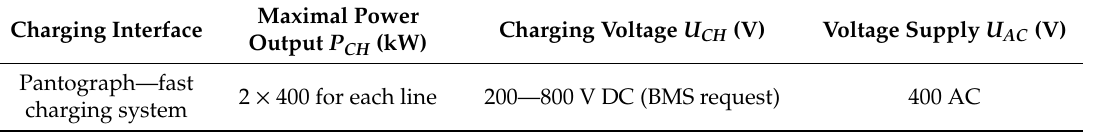
Table 5. Technical parameters of charging points on the Wilanów terminus [21].